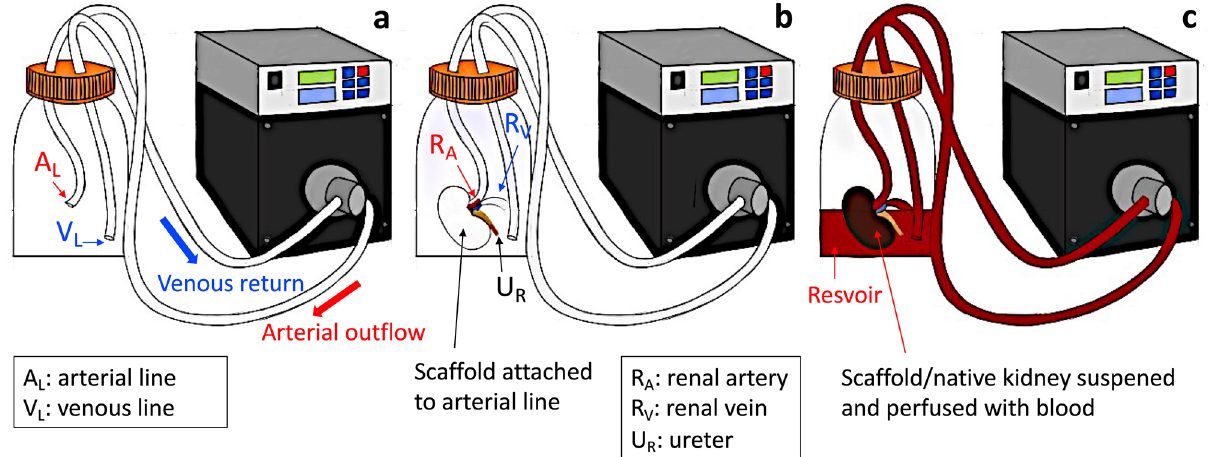
Figure 5. A schematic of the bioreactor model used to perfuse native kidneys and decellularized scaffolds with whole blood. This image illustrates the bioreactor assembly with the arterial (A L ) that receives blood from the arterial outflow and venous (V L ) lines that returns blood dispensed from the kidneys for recirculation via the venous return segment ( a ). A decellularized kidney is suspended in the bioreactor, before blood perfusion, by attaching the cannulated renal artery (R A ) to the arterial line, while the renal vein (R V ), venous line, and ureter (U R ) were all left open to support outflow from the kidney sample and venous return to the pump ( b ). A native/decellularized kidney is attached to the arterial line within the assembly and suspended in a reservoir of approximately 400–500 ml of blood to facilitate perfusion at various